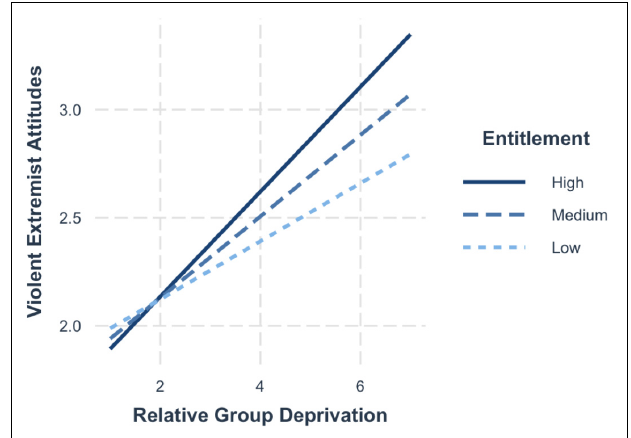
FIGURE 4 | Simple slopes for group deprivation and trait entitlement on violent extremist attitudes.